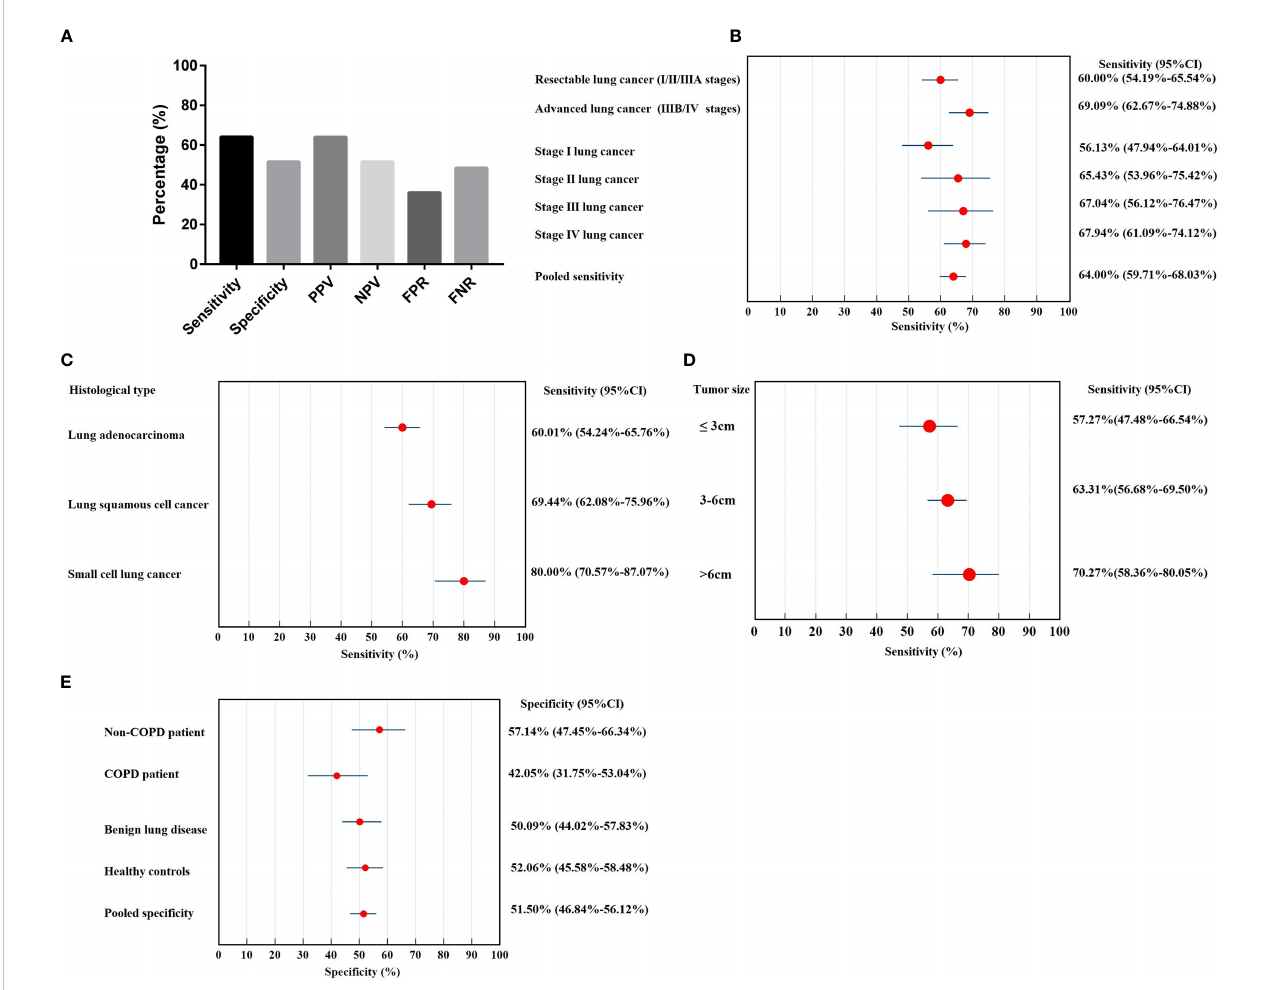
FIGURE 1 The diagnostic value of 7-AABs panel in lung cancer diagnosis. (A) The sensitivity, speci fi city, PPV, NPV, FPR and FNR of 7-AABs in the diagnosis of lung cancer; (B) Sensitivity in subgroups of lung cancer patients strati fi ed by stages; (C) Sensitivity in subgroups of lung cancer patients strati fi ed by histological type; (D) Sensitivity in subgroups of lung cancer patients strati fi ed by tumor size; (E) Speci fi city in subgroups of controls (healthy control, benign lung diseases, COPD and non-COPD). PPV, positive predictive value; NPV, negative predictive value; FPR, false positive rate; FNR, false negative rate; COPD, chronic obstructive lung